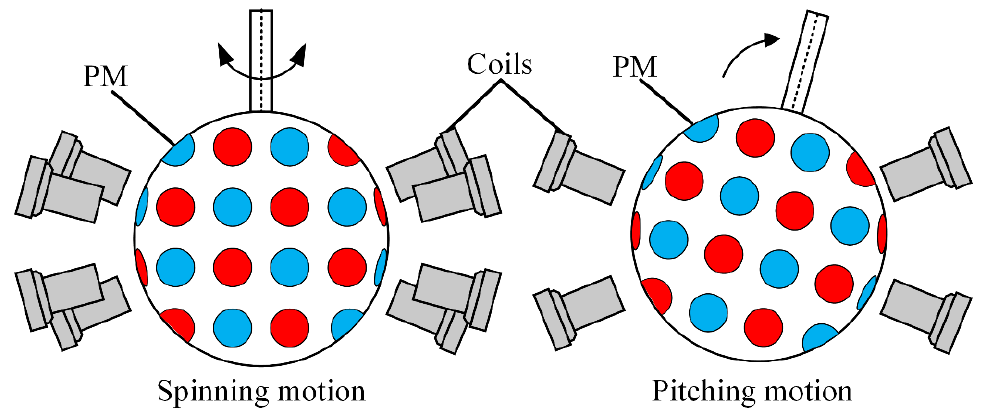
Figure 1. PMSpA structure diagram.